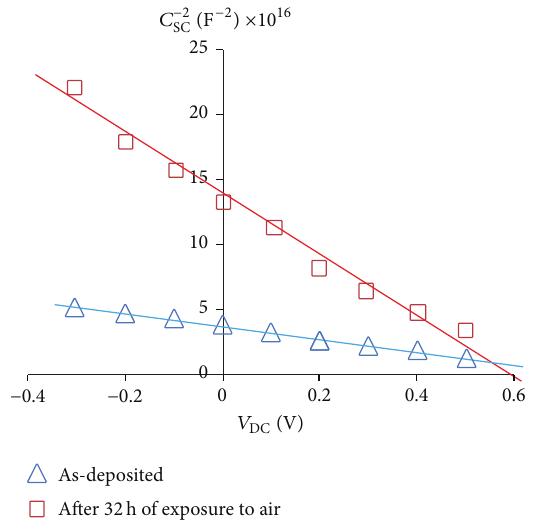
Figure 5: Mott-Schottky curves ( 𝐶 −2 SC versus 𝑉 DC ) performed using 𝐶 SC values determined from impedance spectra measured immedi- ately after the deposition of the ITO/P3HT/Ag structure and after 32 hours of exposition to the air,